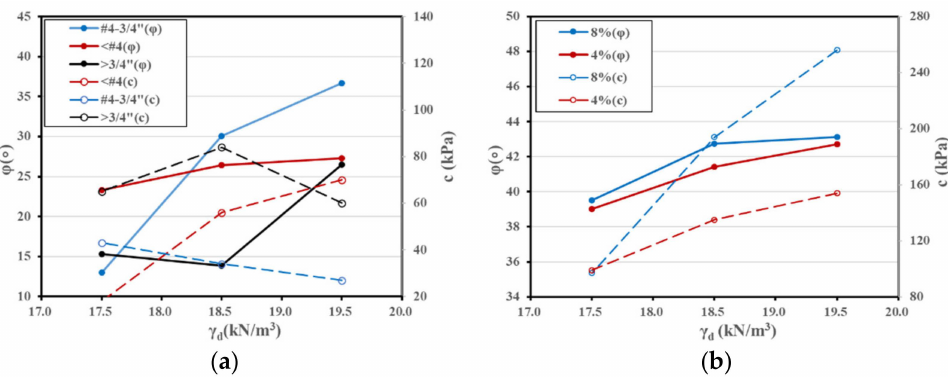
Figure 15. Cohesion values and internal friction circle of the samples for triaxial Unsaturated Unconsolidated Undrain tests: ( a ) mudstone; ( b ) mudstone–cement.